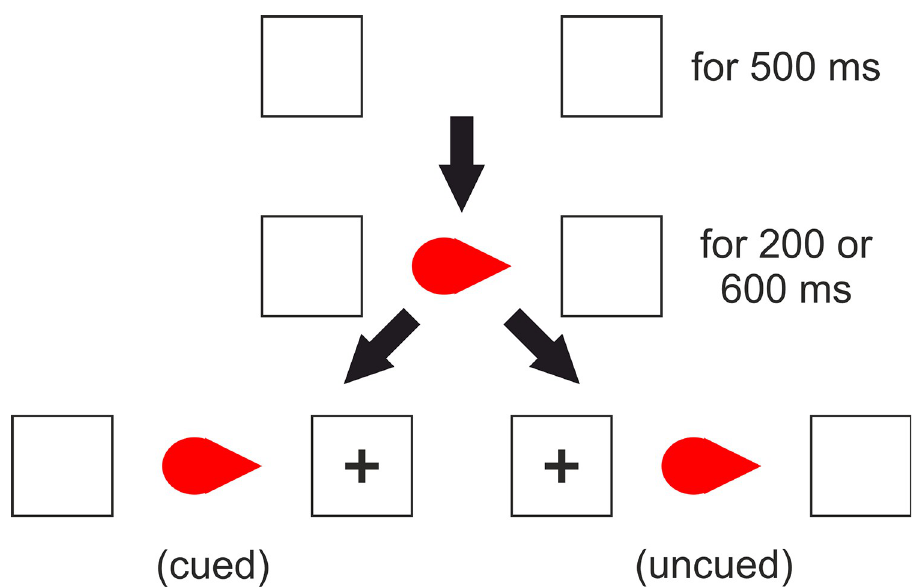
Fig 5. Schematic representation of a trial in Experiment